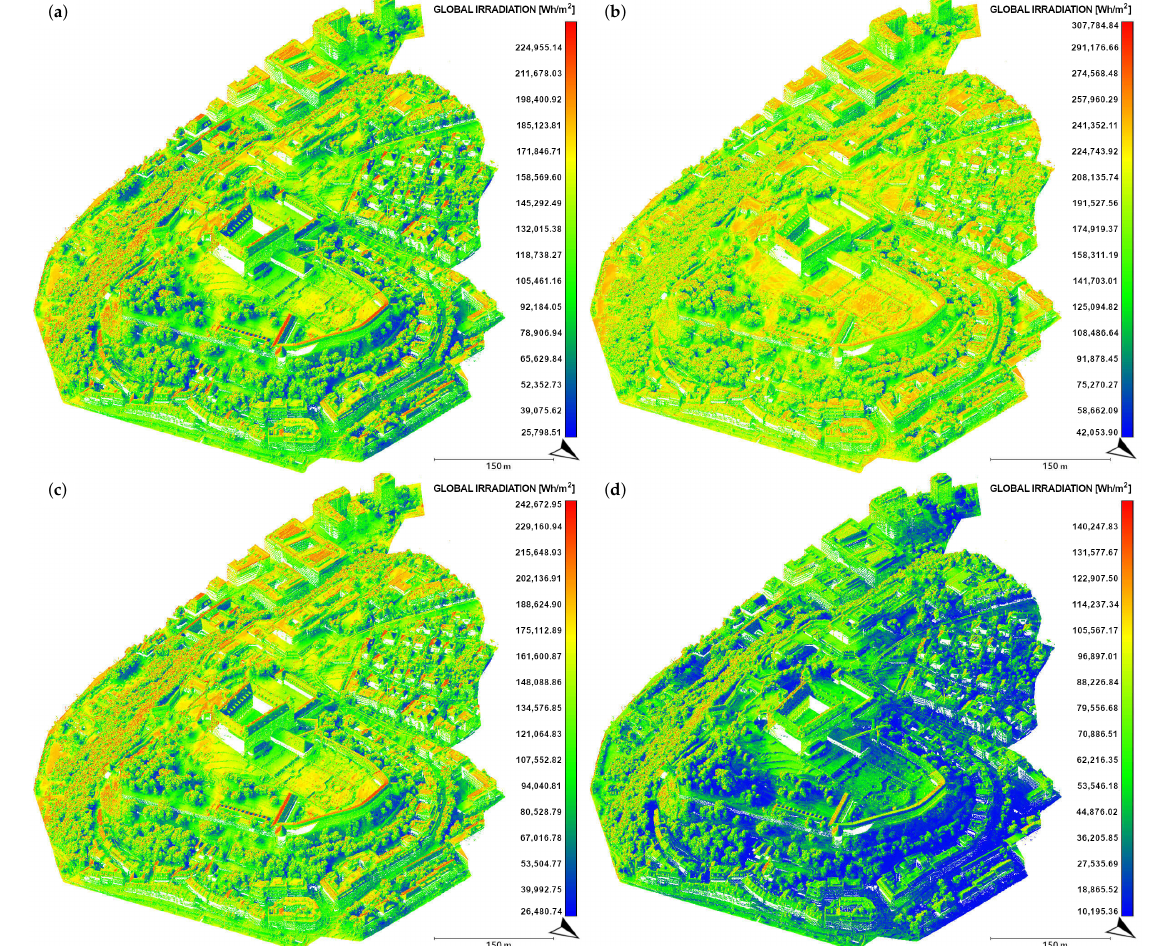
Figure 5. The monthly sums of global solar irradiation on Castle Hill in Bratislava, Slovakia, in ( a ) March, ( b ) June, ( c ) September, and ( d ) December. Data source: ÚGKK SR